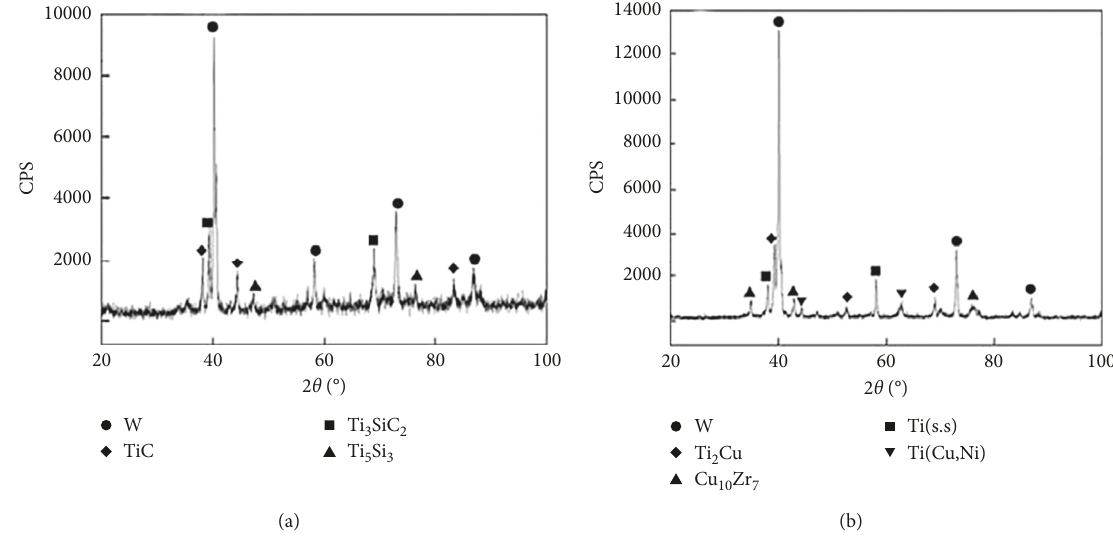
Figure 10: XRD pattern of the joint: (a) interface between C